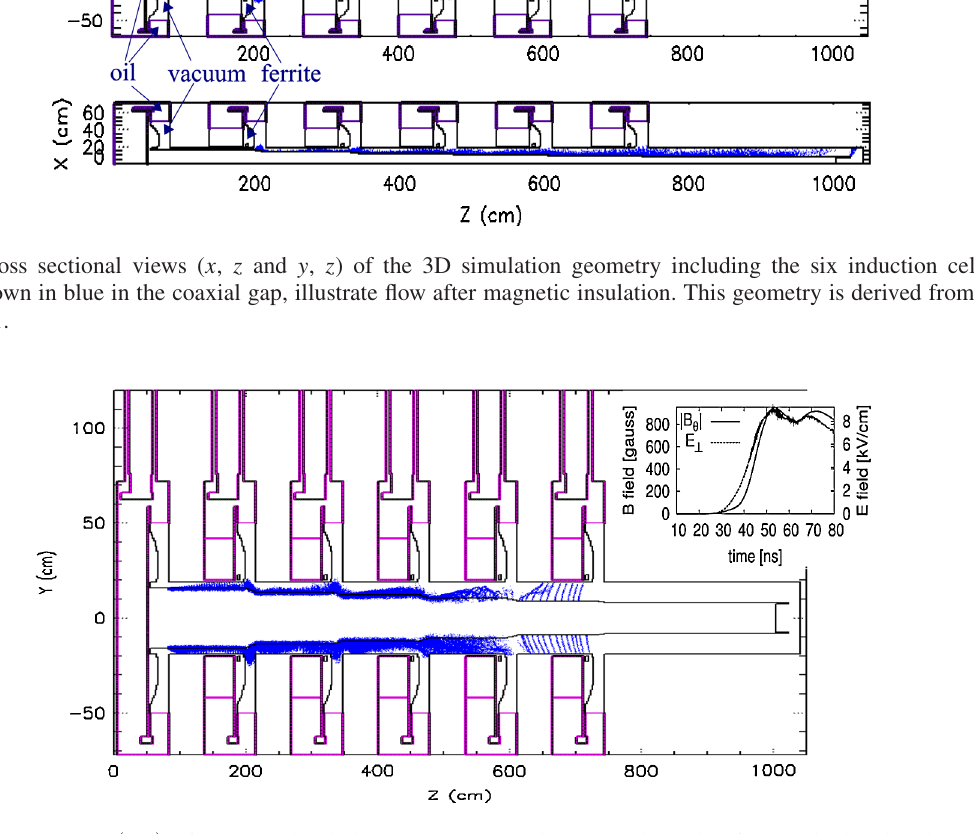
FIG. 4. (Color) Cross section ð y; z Þ of the 3D simulation geometry at 45 ns into the pulse for nominal pulse timings. Electron macroparticles (in blue) illustrate flow as magnetic insulation is being established. The field plot in the inset shows the time history of the E and B fields at r ¼ 35 cm in cavity 4,